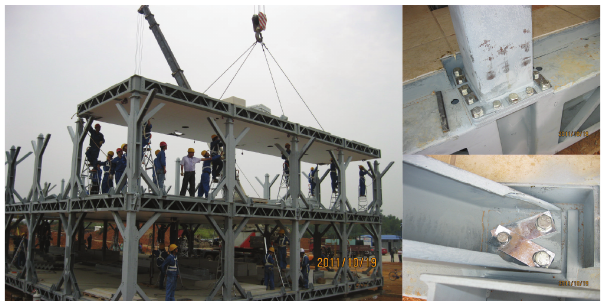
Figure 4: Inclined brace joint.